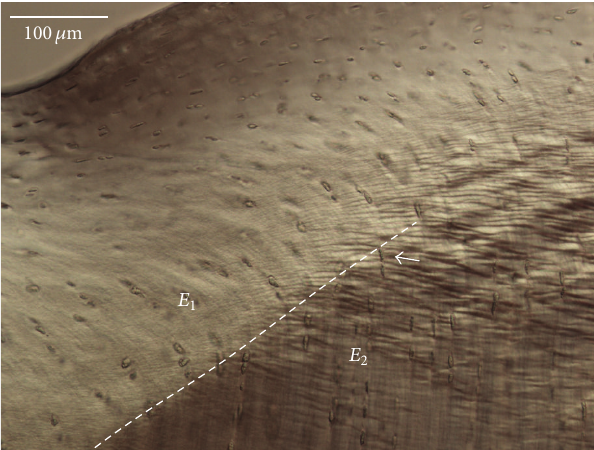
Figure 9: A magnification of region X in Figure 8. The dotted line indicates the structural discontinuity that is obvious between regions 𝐸 1 and 𝐸 2 . The arrow points to the site that was imaged at higher magnification, shown in Figure 10. DIC imaging.